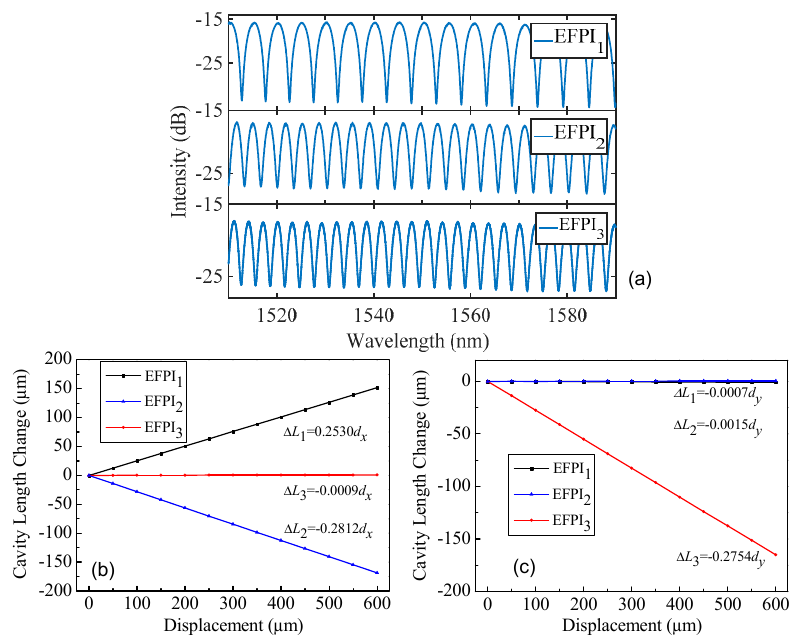
Figure 4. Calibration results of the triaxial displacement sensor. ( a ) Interference spectra recorded from the triaxial displacement sensor for the initial cavity length settings. ( b ) The changes in cavity lengths of the three EFPIs as a function of applied displacements along the X direction ( d x ). ( c ) The changes in cavity lengths of the three EFPIs as a function of applied displacements along the Y direction ( d y ). In the experiment, the mirror component was fixed on an optical table, and the optical fiber component was positioned by an optical stage. The coordinate system used in the experiment is the same as the XYZ system shown in Figure 2a.